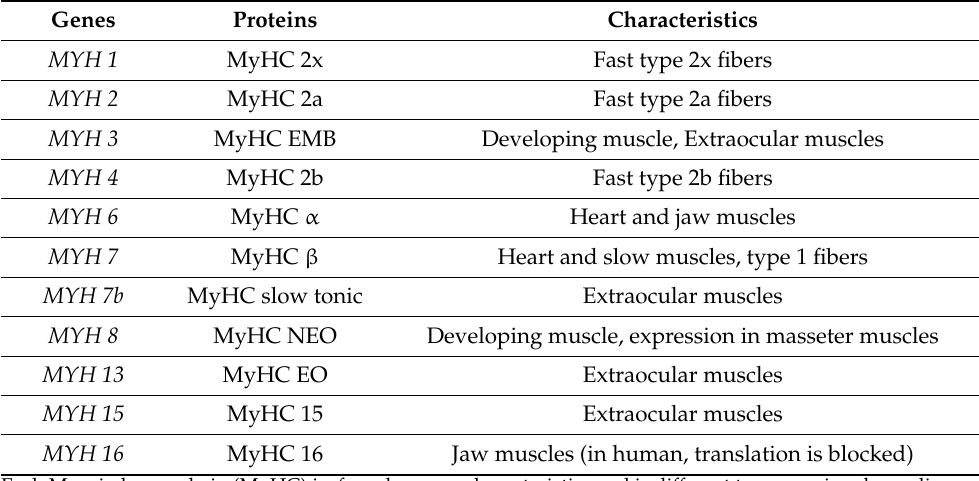
Table 1. Comparison of myosin heavy chain